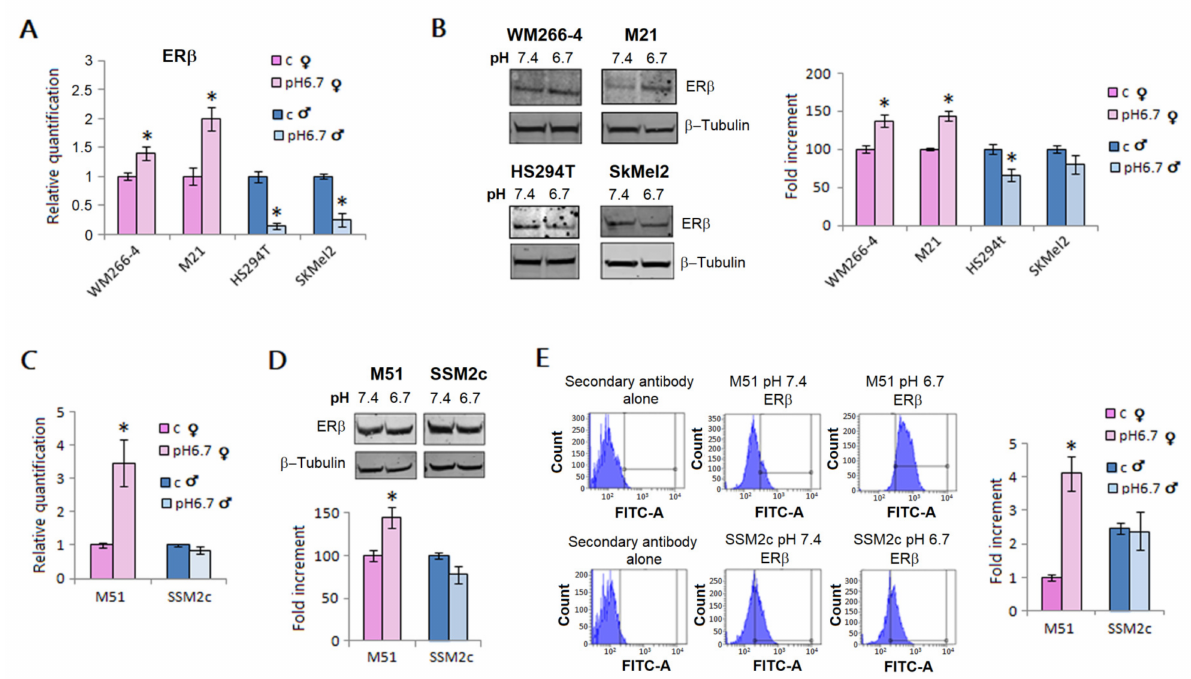
Figure 1. ER β expression in melanoma cells of male and female patients. mRNA ( A ) and protein ( B ) levels of ER β in female (WM266-4, M21) and male melanoma cells (HS294t, SKMEL2) grown in standard (pH 7.4) or acidic medium (pH 6.7) for 24 h. mRNA level and protein expression of ER β in M51 (female) and SSM2c (male) melanoma cells grown in an acidic medium for 24 h, performed by Real-time PCR ( C ), Western blotting ( D ), and flow cytometry ( E ). Histograms represent the mean ± SEM of at least three independent experiments. * p < 0.05 compared with control